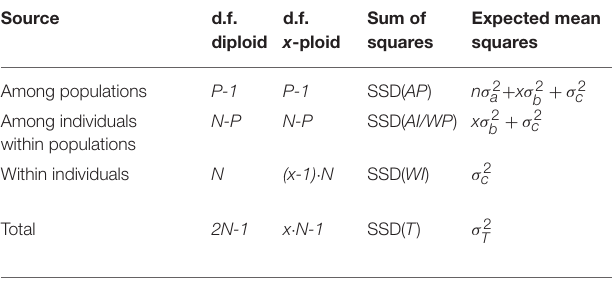
TABLE 1 | Outline of the AMOVA framework for a single group of populations with the degrees of freedom (d.f.) both given for diploids and generalized for any ploidy level x (except haploid).